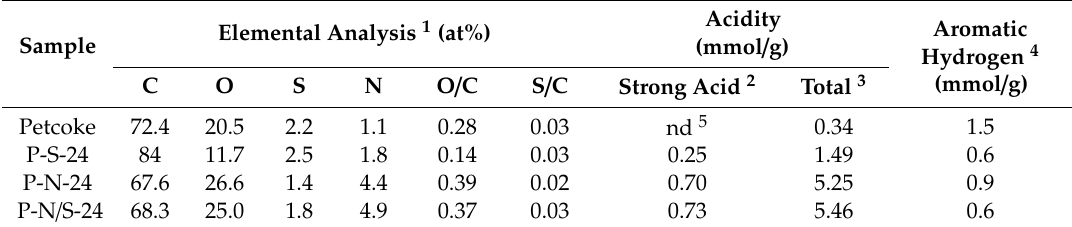
Table 1. Surface chemical properties of petcoke before and after various acid treatments. Sample